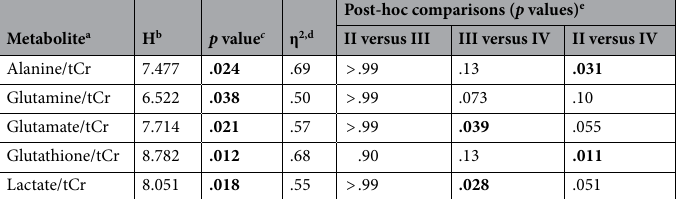
Table 2. Differences in tumor metabolite concentrations as a function of WHO grade. tCr = creatine + phosphocreatine. a Metabolite concentrations were normalized to tCr. b Non-parametric Kruskal–Wallis H-test. c Bolded values indicate statistical significance ( p ≤ .05). d Effect size was calculated using η 2 . e p values adjusted using the Bonferroni correction for comparing tumor grade within